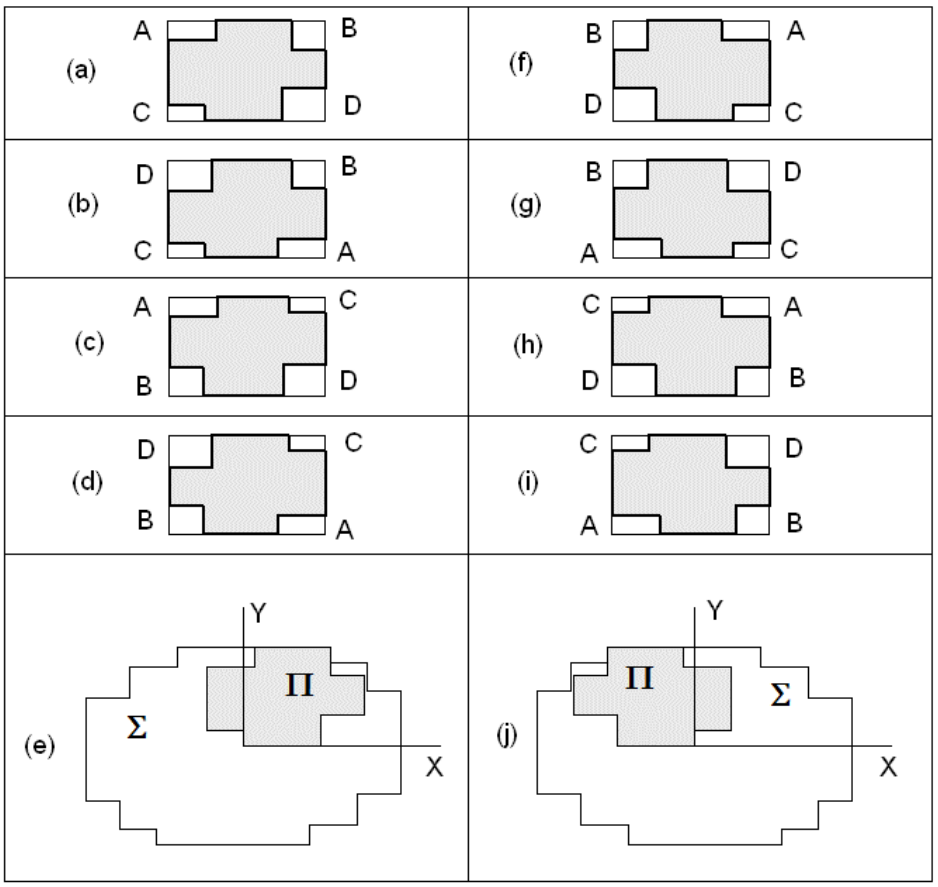
Figure 11. Set of collector shapes that generate identical annual incident radiation results. The forms ( a – d ) generate the same envelope Σ ( e ) and the set of symmetric figures with respect to a vertical axis ( f – i ) generate a symmetric envelope Σ’ of Σ ( j